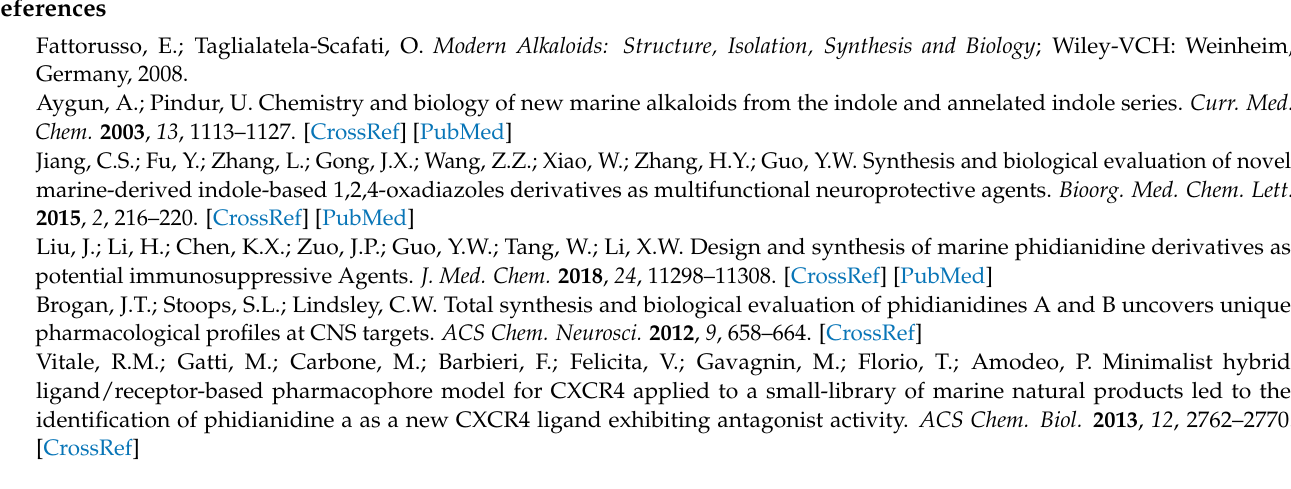
Figure 15. The structure of compounds 79 , 80 .